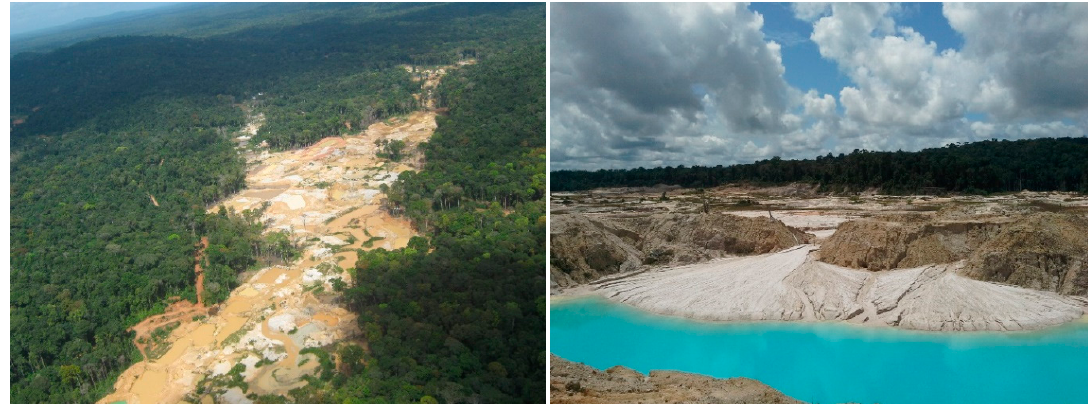
Figure 1. An example of mining activities inside the forest near Mahdia, known as one of the hot spots for alluvial gold mining in Guyana. Gold mining is one of the key drivers of carbon emissions through deforestation and forest degradation. The photo on the left shows the aerial view and the photo on the right illustrates the ground conditions of a typical mining site in Guyana.